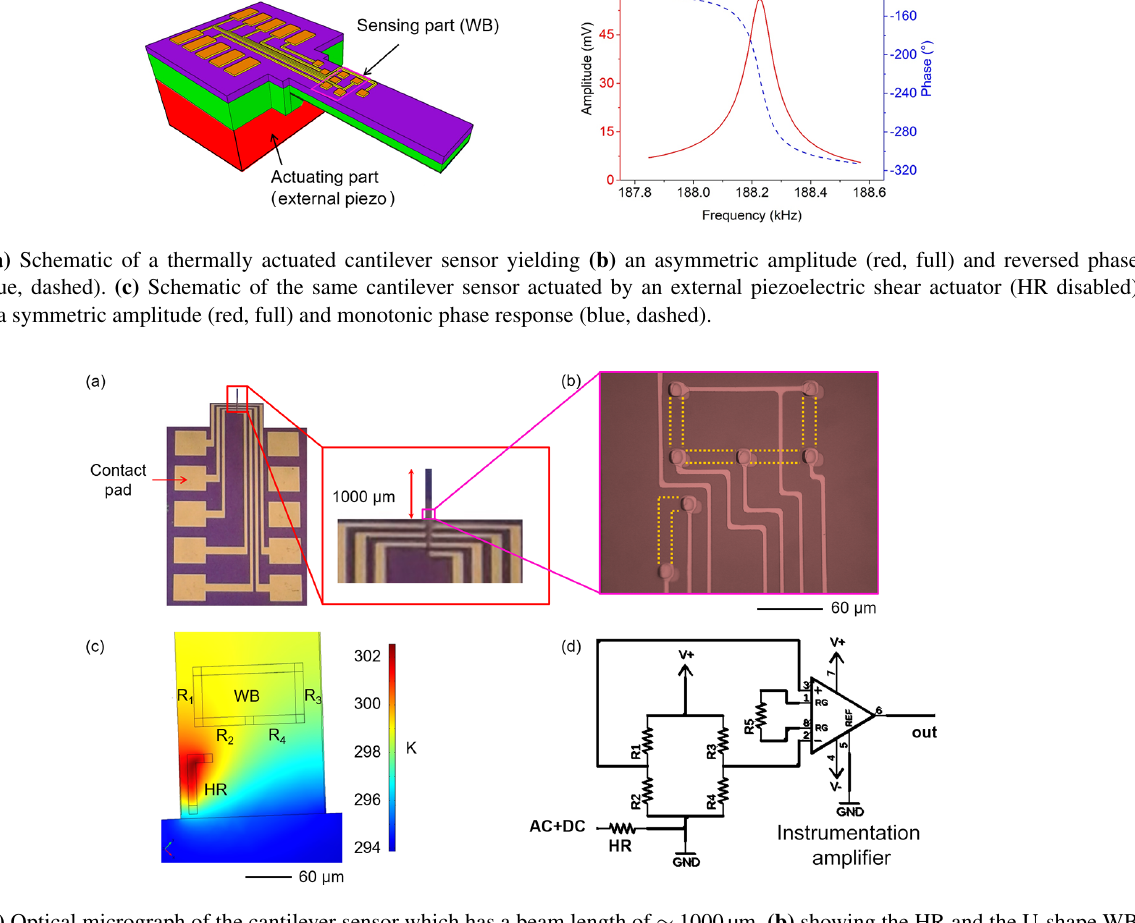
Figure 2. (a) Optical micrograph of the cantilever sensor which has a beam length of ∼ 1000µm, (b) showing the HR and the U-shape WB at the clamp end with the dimensions of the resistors R 1 to R 4 of 60 × 10µm 2 . Furthermore, (c) shows the temperature distribution around HR obtained by FEM (COMSOL Multiphysics 4.4b). In (d) the electrical circuit diagram with the exciting and sensing parts is displayed ( V + is connected to R 1 and R 3 represents the supply voltage of the